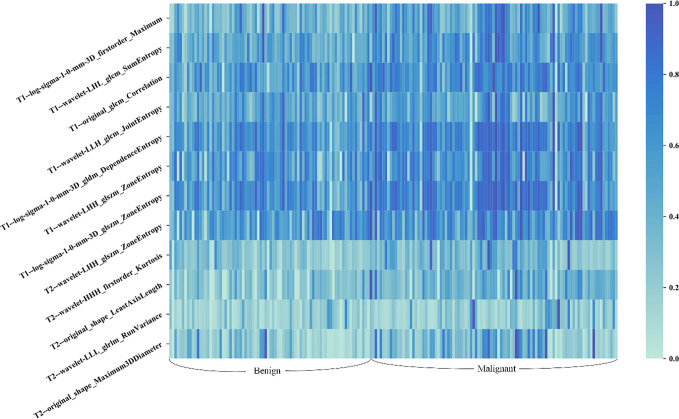
Heat map of the selected radiomic features for T1 + C and T2 schemes. Each row of the heat map represents a radiomic feature and each column represents a patient. Different shades of blue represent different values of radiomic features. The difference in T1 + C feature values between benign and malignant lesions was slightly more distinct than that of T2 features.